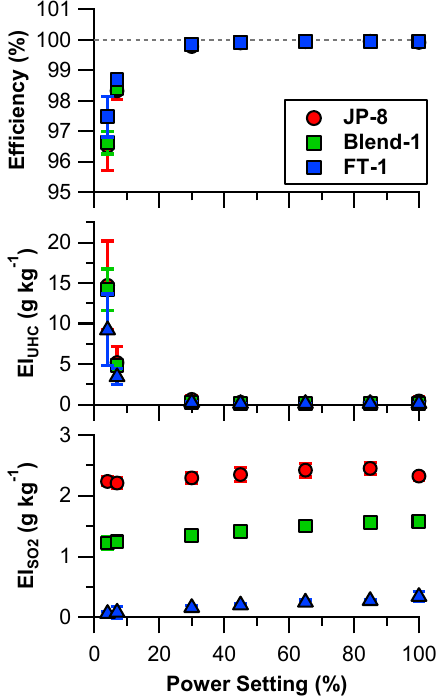
Fig. 2. Combustion efficiency, EI UHC , and EI SO as a function of 2 engine power for JP-8 and FT-1 fuels. FT-2 and Blend-2 results were similar to FT-1 and Blend-1 measurements. Combustion efficiency was calculated based on the CO and unburned hydrocarbons. Data are solely from the #3 engine. One-sigma standard deviations are shown as error bars. At high power, combustion efficiencies varied by less than 0.1% between measurements and between fuel types. Standard deviations are smaller than 0.1gkg − 1 for EI UHC at high power and EI SO at all 2